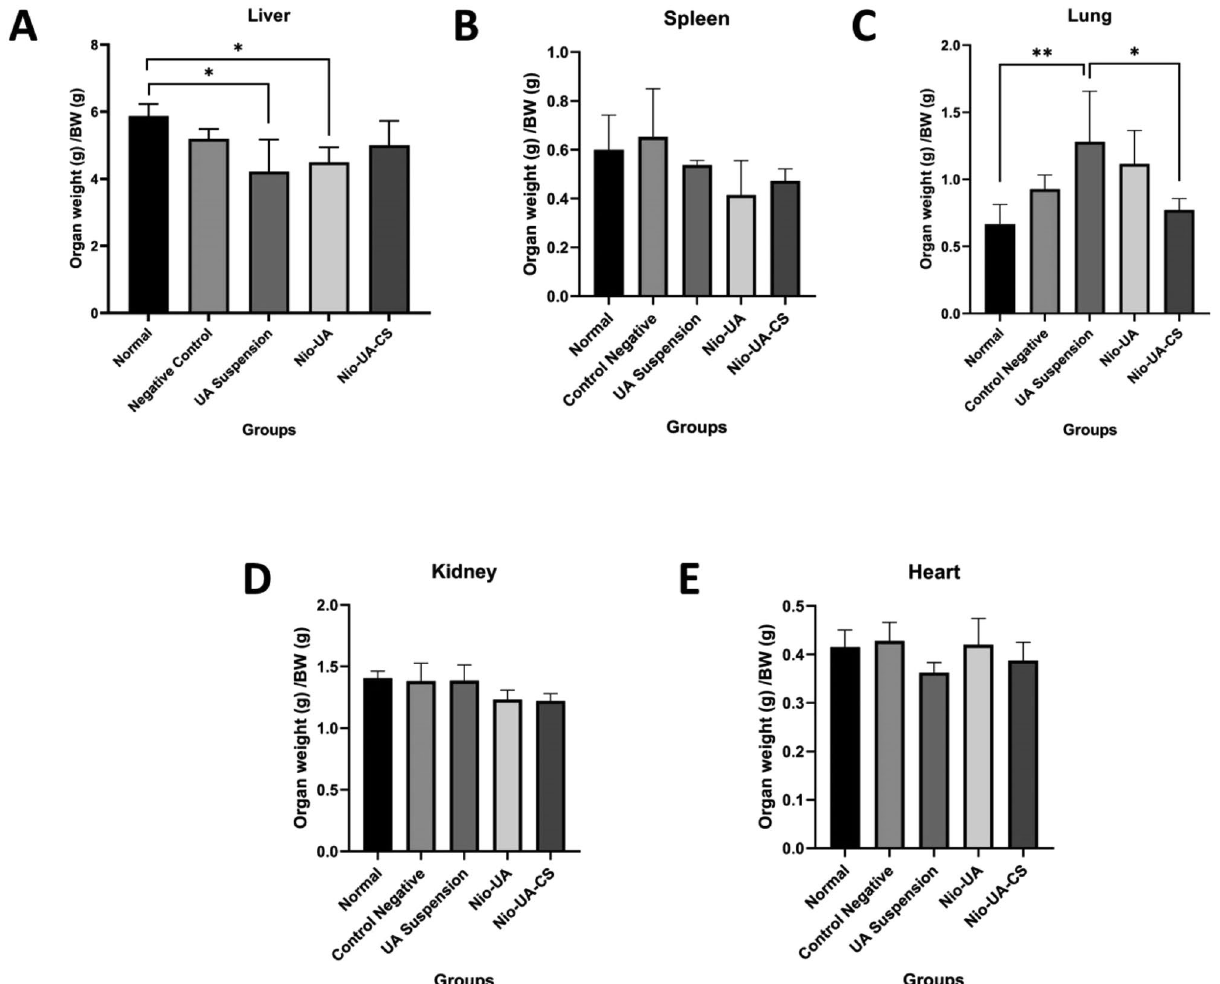
Figure 4. Graph of the relative weight of organs ( A ) liver, ( B ) spleen, ( C ) lungs, ( D ) kidney, ( E ) heart in the normal group and the group which had been NDEA induced with a dose of 25 mg/kgBW and UA